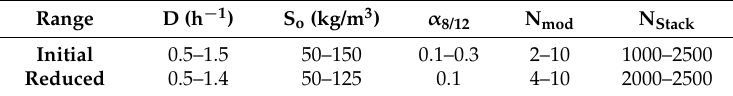
Table 1. Initial and reduced ranges of the decision variables.